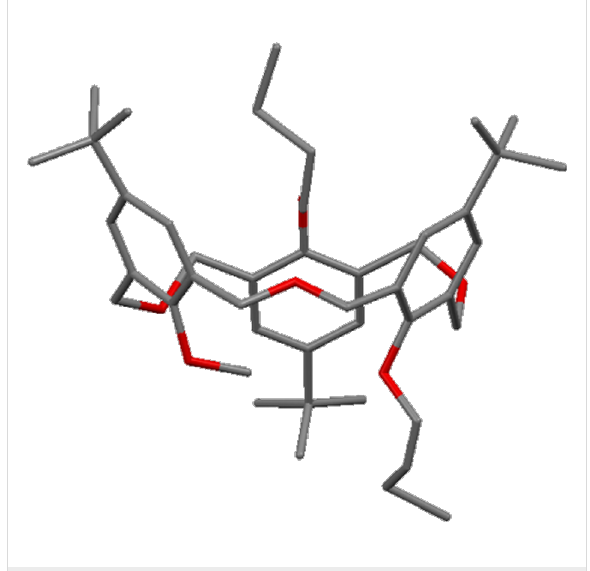
Figure 20: X-ray crystal structure of oxacalix[3]arene 49 capable of chiral selectivity (CSD ID HIGMUF) [65].